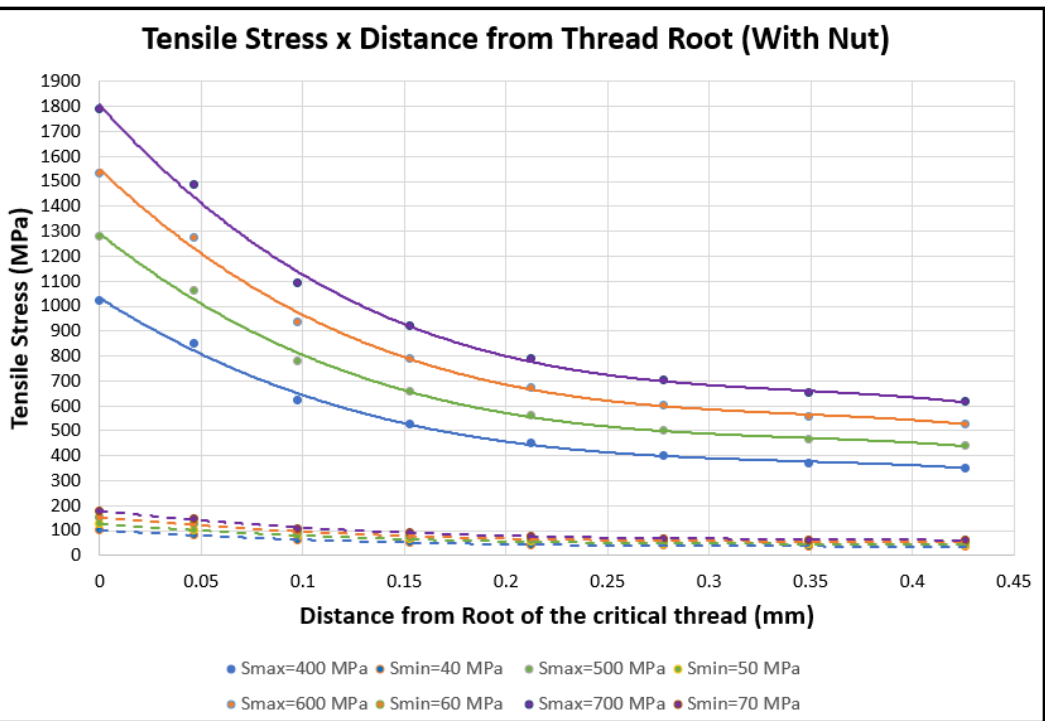
Figure 19. Tensile stress (MPa) from the thread root for studs.